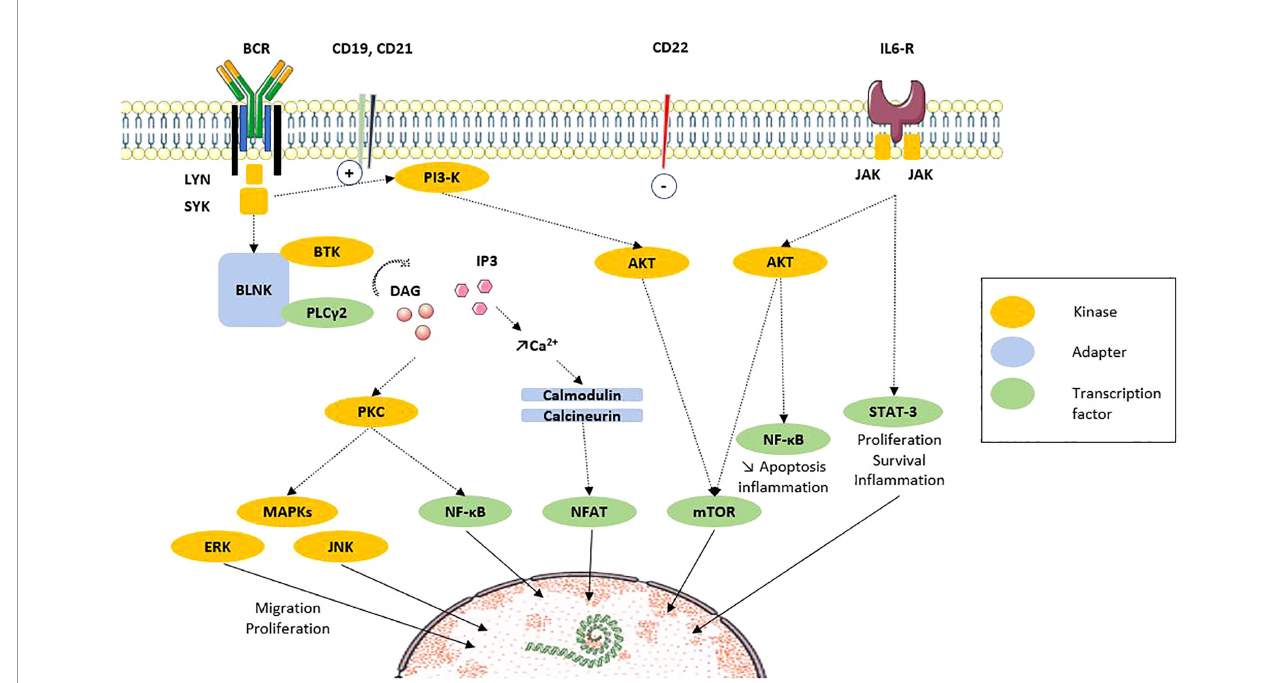
FIGURE 2 | B-cell signaling via BCR and costimulation molecules (adapted from Dal Porto et al. Mol Immunol, 2004 [32)]. After ligation of antigen on the B-cell antigen receptor (BCR) at the membrane, signals are transduced and propagated by several protein phosphorylations, modi fi cations and interactions. The end point is the regulation of transcription factors that regulate the expression of genes. Recent results highlight the participation of intracellular signaling perturbations in B-cell including defective phosphorylation of MAPK, STAT3 or mTOR molecules. Solid line: translocation. Dotted line: direct action. AKT, protein kinase B; BCR, B-cell receptor; BLNK, B-cell linker protein; BTK, Bruton ’ s tyrosine kinase; CD, cluster of differentiation; DAG, diacylglycerol; ERK, extracellular signal-regulated kinases; IL, interleukin; IL6-R, IL6 receptor; IP3, inositol triphosphate; JAK, Janus kinases; JNK, c-Jun N-terminal kinase; Lyn, Lck/Yes novel tyrosine kinase; MAPK, mitogen associated protein kinase; mTOR, mammalian target of rapamycin; NFAT, Nuclear factor of activated T cells; PI3K, phosphoinositide 3-kinase; PLC g , phospholipase C g 2; PKC, protein kinase C; STAT3, signal transducer and activator of transcription 3; SYK, spleen tyrosine